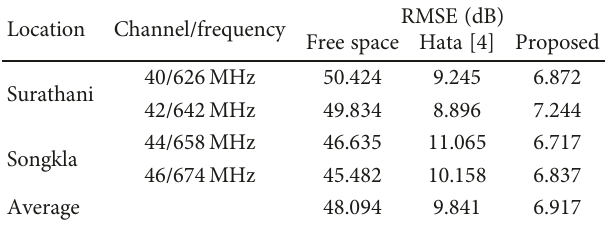
Table 4: RMSE calculative values.